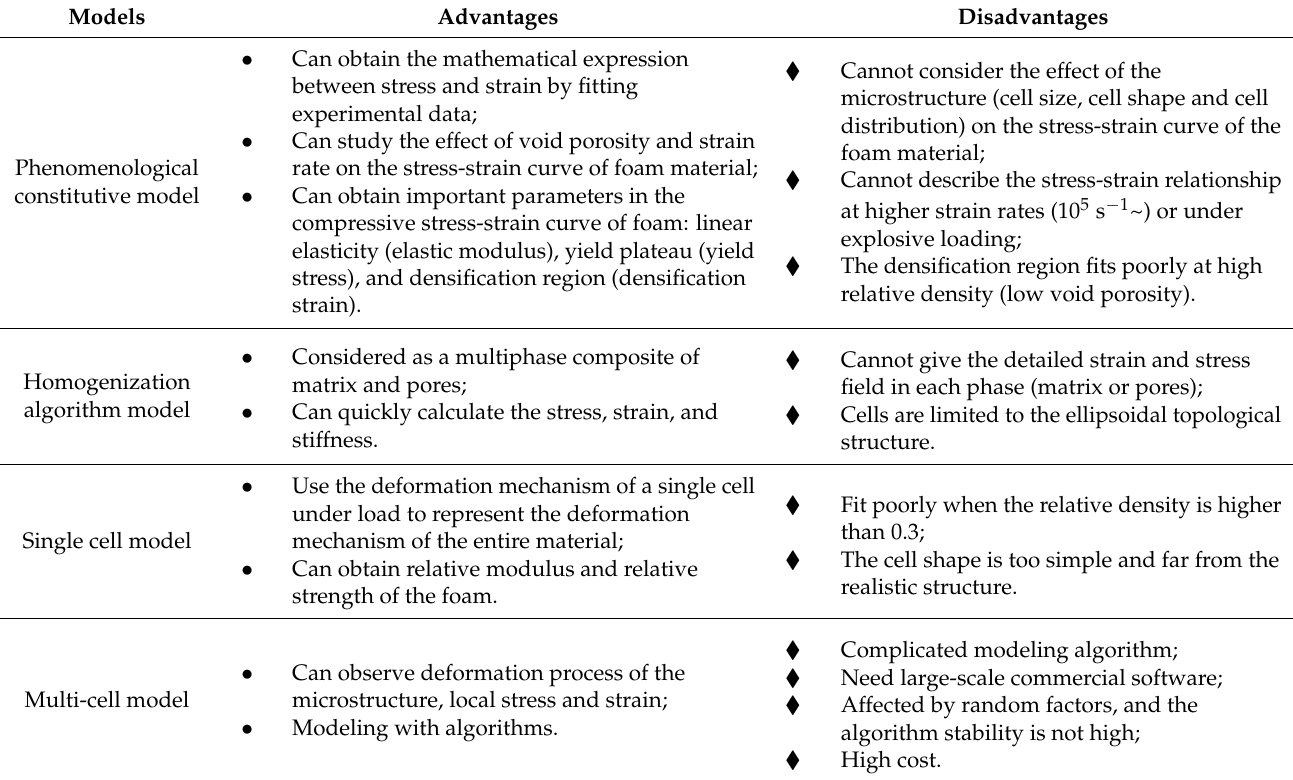
Table 1. Performance comparison of various cellular medium mechanical